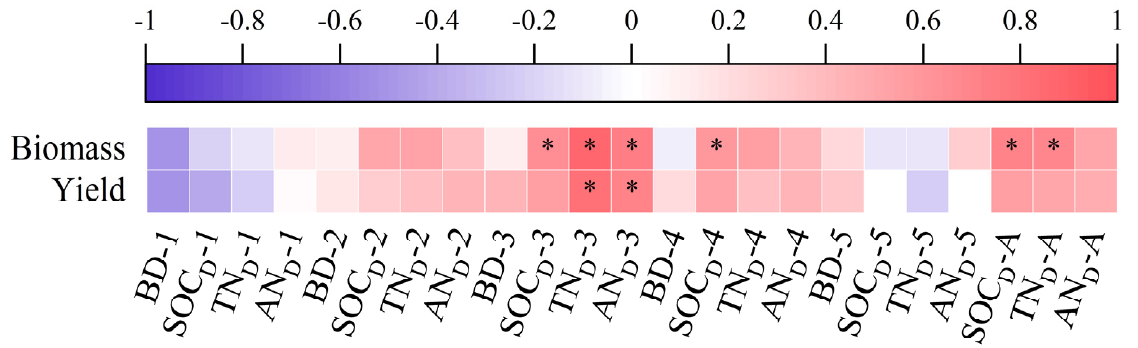
Figure 3. The correlation analysis of rice grain and biomass yield with soil bulk density and C and N density of different soil layers. − 1, − 2, − 3, − 4, − 5, -A represent 0–10 cm, 10–20 cm, 20–30 cm, 30–40 cm, 40–50 cm, 0–50 cm soil, respectively. * Means statistical significance at p = 0.05.